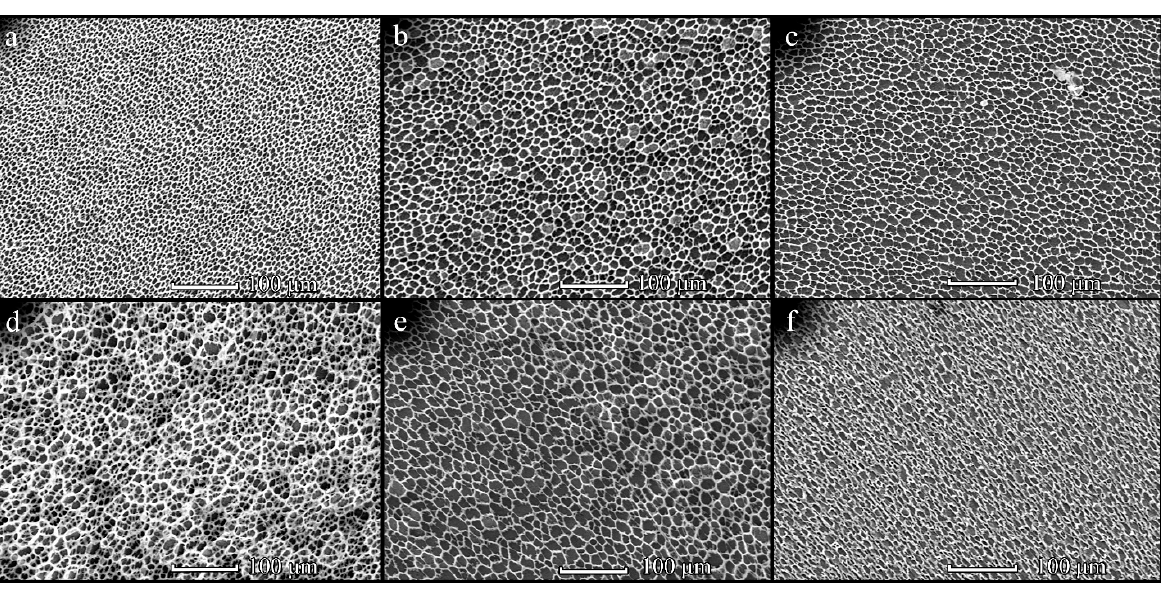
Figure 2. SEM-images of the PHB1800 films obtained from solution with concentrations of 5 ( a , d ), 10 ( b , e ) and 20 ( c , f ) mg/mL upon L = 1 cm. The solution volume is 150 ( a – c ) and 450 ( d – f ) μ L.